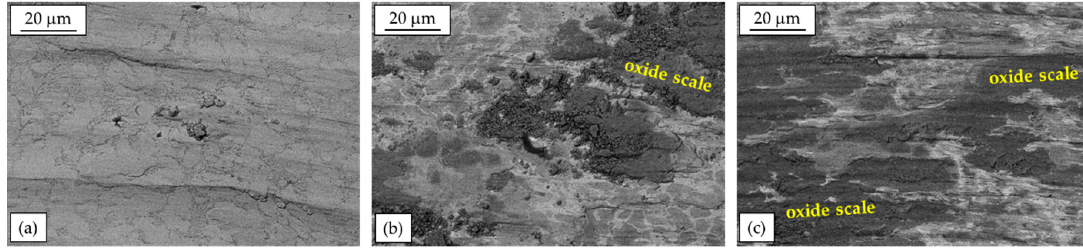
Figure 7. SEM analyses of wear tracks of ( a ) Zamak 2, ( b ) ZnAl15Cu1, and ( c ) ZA27 obtained by pin-on-disk test at 100 m-1 N and 100Cr6 counterpart.